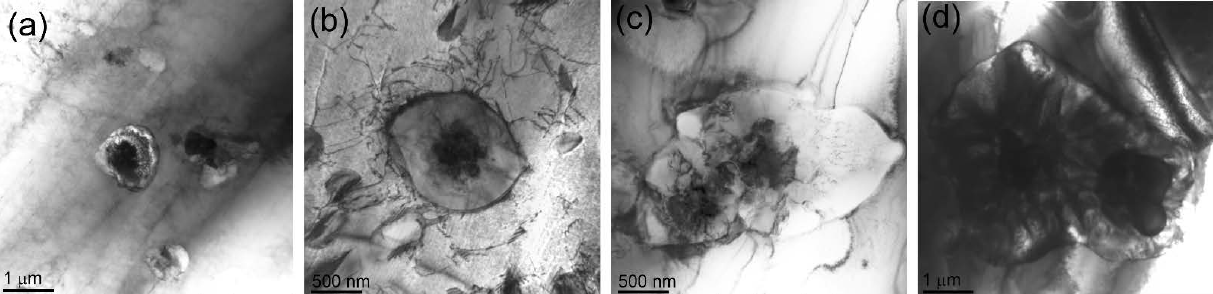
Figure 6. TEM bright-field images of Cr-rich particles in composites ( a ) 5% Ud, ( b ) 10% Ud, ( c ) 15% Ud and ( d ) 25% Ud.